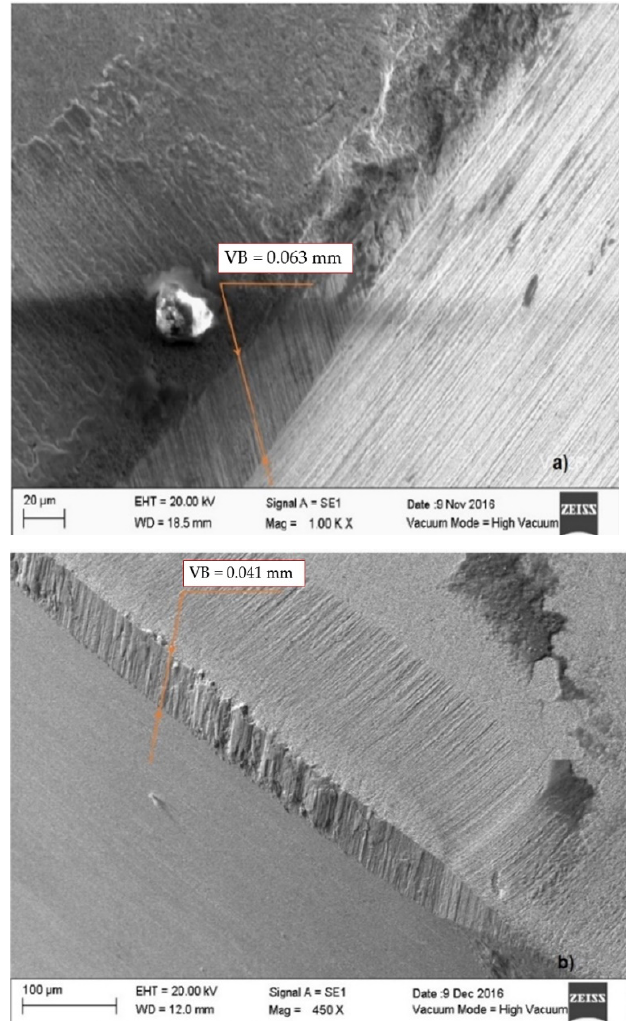
Figure 5. Wear on the incidence surface of the cutting tool for V = 200 m/min and f = 0.1 mm/rev: ( a ) dry and ( b ) with MQL.